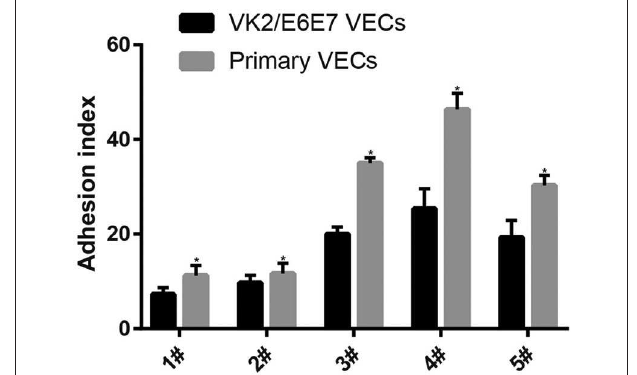
FIGURE 1 | Adhesion of the five Lactobacillus strains to VECs. Two kinds of VECs, VK2/E6E7, and primary VECs were used in this experiment. The adhesion of the five Lactobacillus strains to the VK2/E6E7 VECs, compared with that to primary VECs, was observed. Lactobacillus strains were identified by their color and morphology after Gram staining. Lactobacillus adhesion was assessed using the adhesion index: Adhesion index, adhering Lactobacillus /cell number. The adhering Lactobacillus number is the total quantity of Lactobacilli adherent to 50 intact VECs, which were selected at random. These intact VECs were observed, and the Lactobacillus number was counted using a light microscope at 1000 × magnification under oil immersion. Each adhesion index value is shown as the mean ± SD. Student’s t -test was performed. * P < 0.05; the difference in the adhesion of each Lactobacillus strain to the VK2/E6E7 and primary VECs was statistically